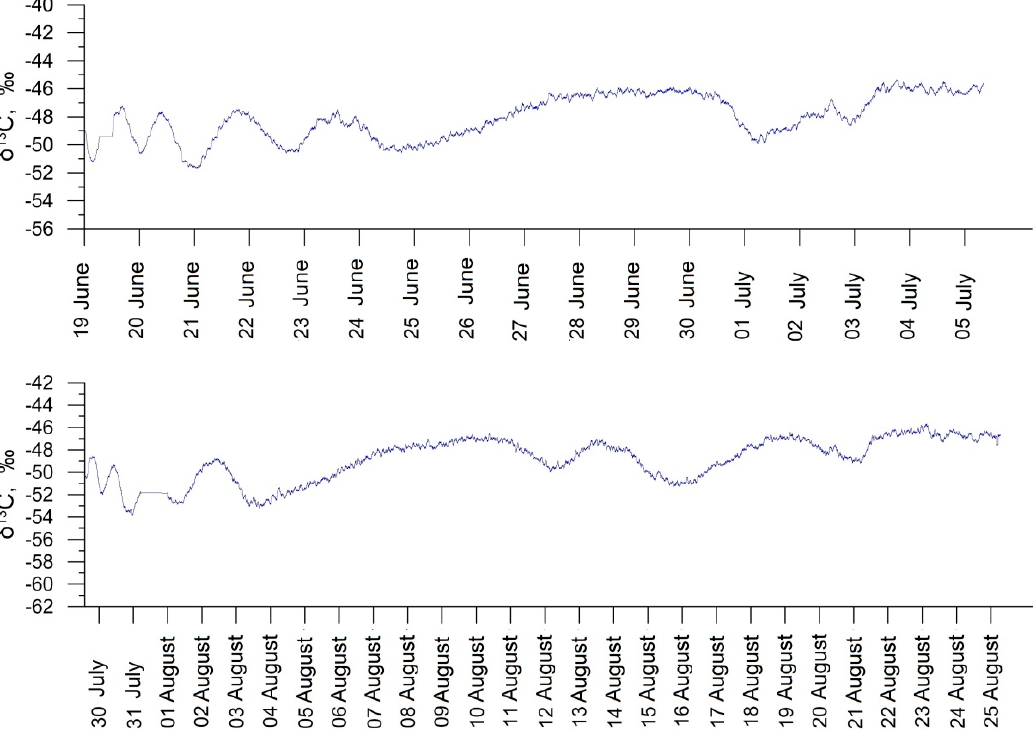
Figure 6. δ 13 C variability during АМК -83, АМК -84, and АМК -85 (1 h averaging). The Keeling plot method was used for more accurate analysis of potential methane contributors [46–48]. The largest possible range of mixing ratios of СН 4 in the air mass is required to ensure maximum accuracy in determining the isotopic characterization of excess methane in the air mass. The difficulty in identifying sources during ship-borne measurements is that the air flow is not uniform and accumulates methane from several sources while passing over different areas. Figure 7 shows examples of Keeling plots.